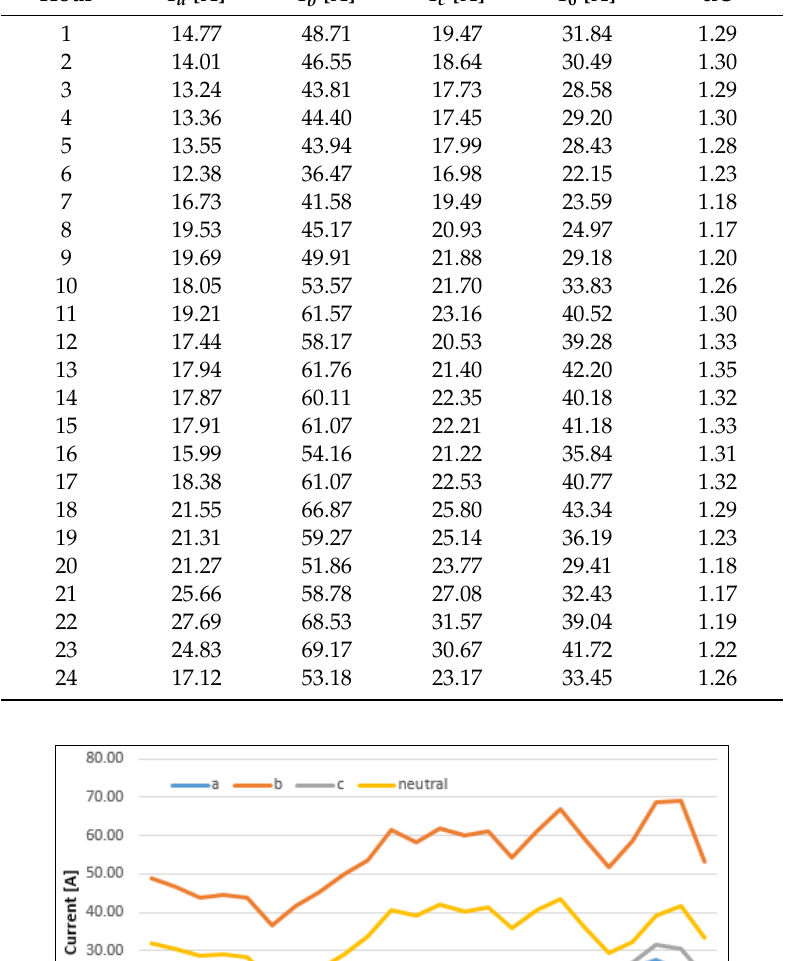
Table 5. Synthesis on the characteristics of the consumers from the analyzed EDN. Table 6. The currents in the conductors of the first branch, SP-Pillar 8, initial case.